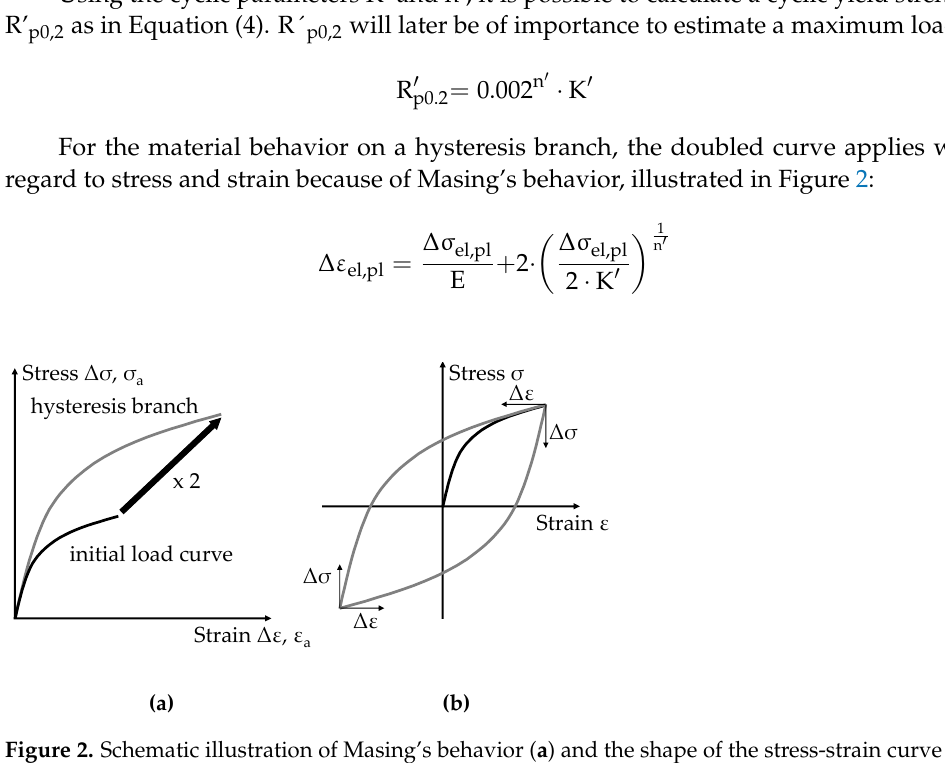
Figure 2. Schematic illustration of Masing’s behavior ( a ) and the shape of the stress-strain curve due to Masing’s behavior ( b ).